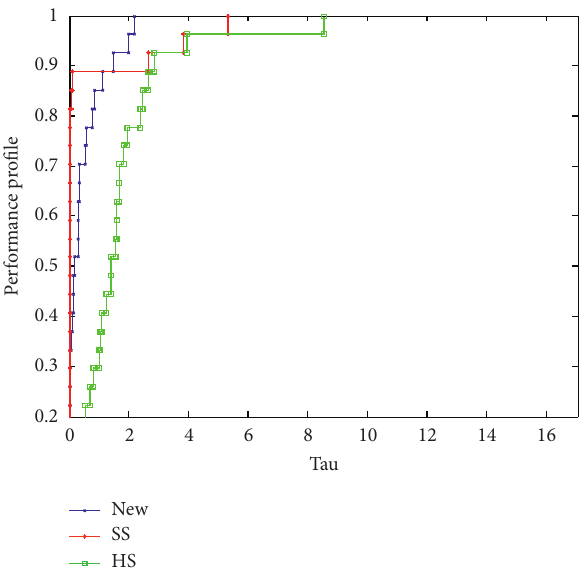
Figure 4: Performance profiles of the CPU. Table 2: Comparison between CG-BAT and classical algorithm on benchmark functions ( F 1 ∼ F 10).